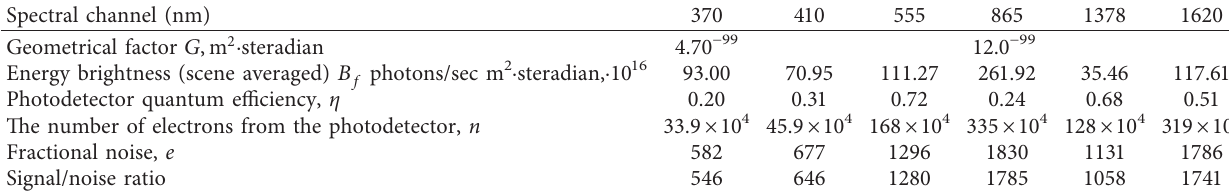
Table 4: The signal/noise ratio estimate.